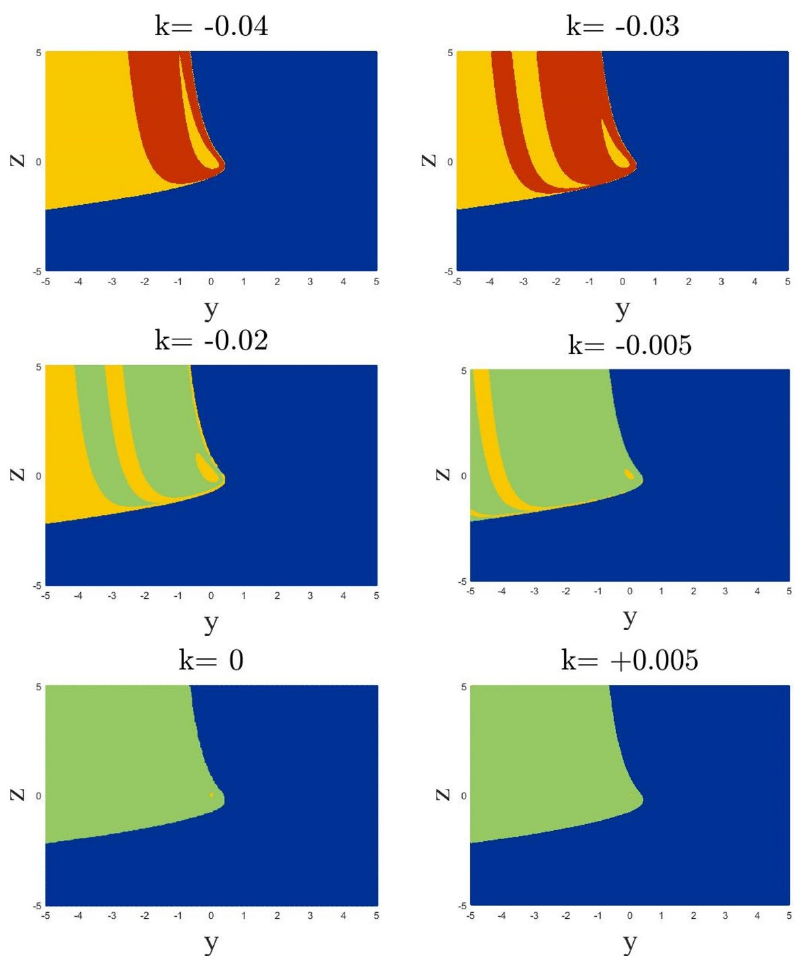
Figure 4. 2 − D cross − sections of basins of attractions of System (1). Initial conditions belonging to blue regions lead to unbounded oscillation. The yellow part contains initial conditions that show the system to its stable equilibrium. Periodic and chaotic attractors emerge from the red and green points in the y-z plane. The initial condition for the x variable is selected as x = k for all